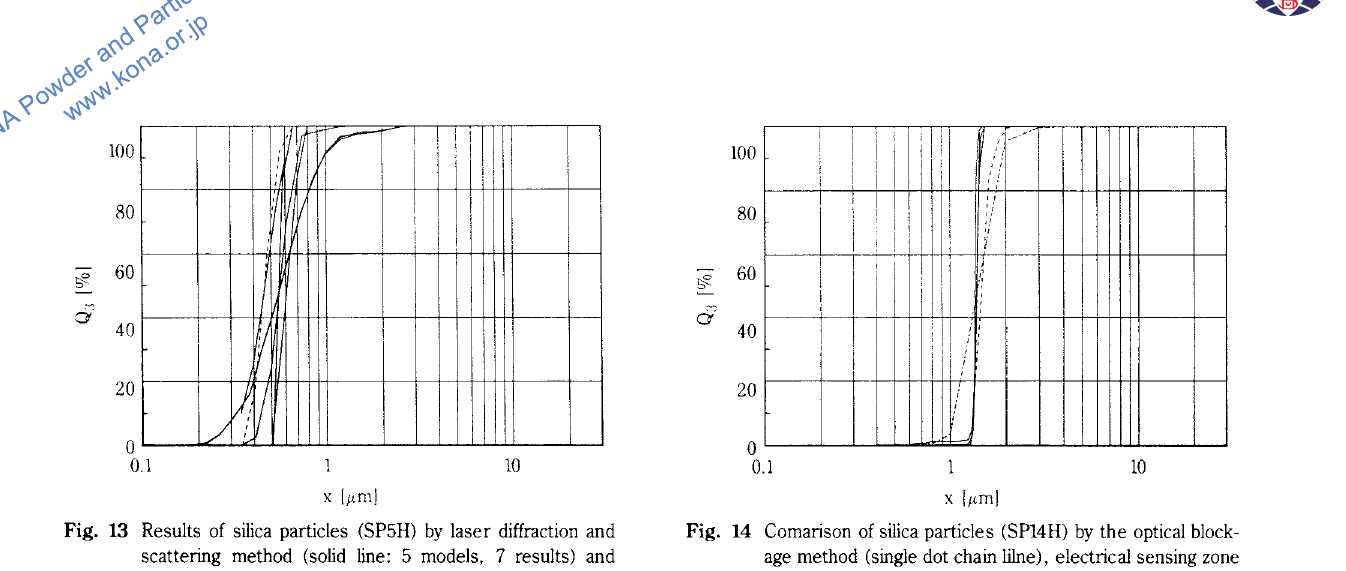
Fig. 13 Results of silica particles (SP5H) by laser diffraction and scattering method (solid line: 5 models, 7 results) and photon correlation method (dotted line)